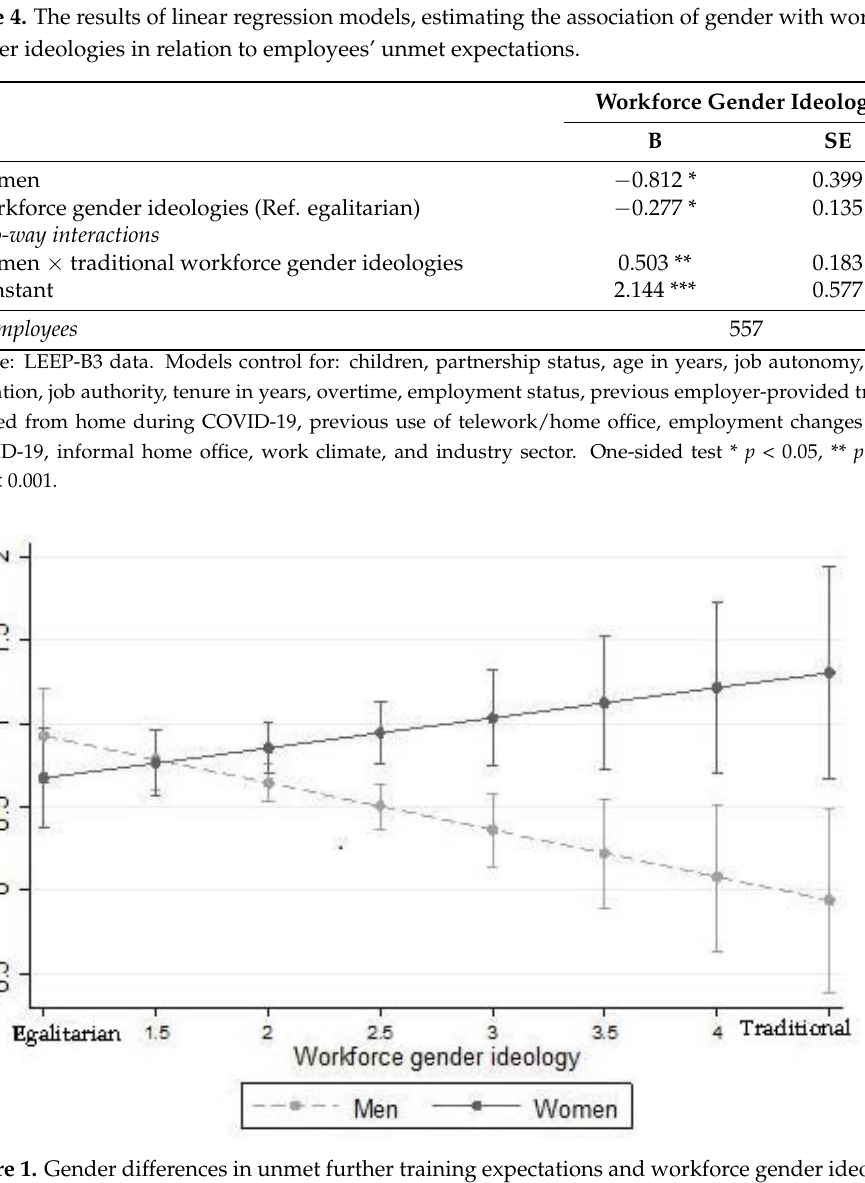
Table 4. The results of linear regression models, estimating the association of gender with workforce gender ideologies in relation to employees’ unmet expectations.